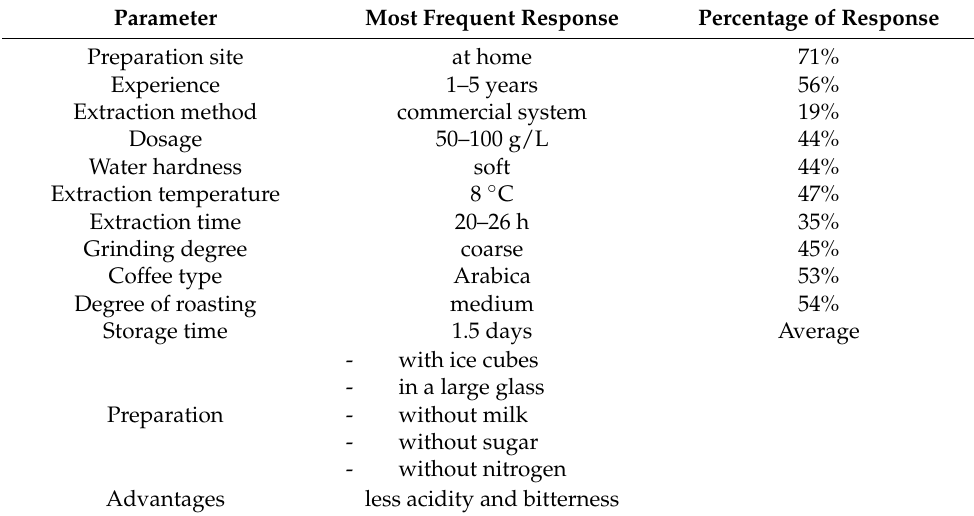
Table 6. Summary of most typical conditions for cold brew